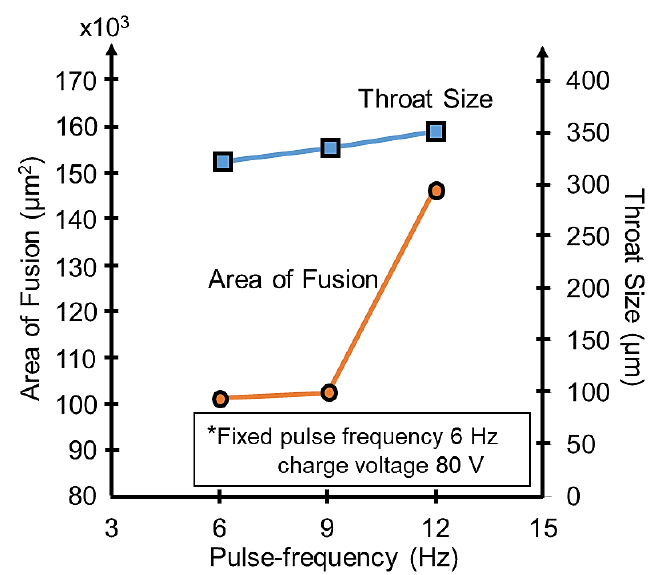
Figure 13. E ff ect of pulse frequency on area of fusion and throat Figure 13. Effect of pulse frequency on area of fusion and throat size.